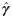
Scenario II. Estimated values of case fatality (γ^) and case recovery (β^) ratios, as computed by least squares using a rolling window (see in Methodology).Solid lines correspond to the mean values and dashed lines to lower and upper 90% confidence intervals.